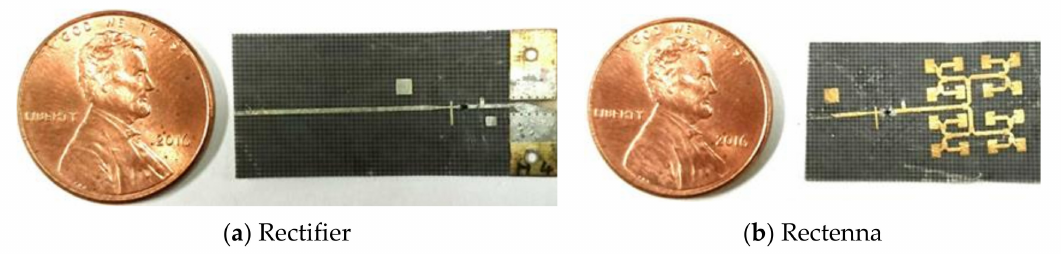
Figure 15. 94 GHz rectenna: ( a ) rectifier and ( b ) rectenna.